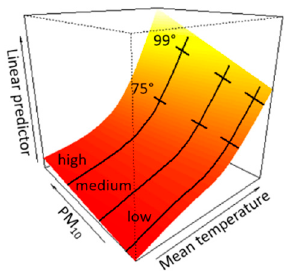
Figure 1. Example of the tensor smoother depicting the joint non-linear association between mean temperature and PM10 on non-accidental mortality. The graph shows the percentiles chosen to show effect estimates of temperature (75th and 99th percentiles of temperature distribution) and the sections corresponding to low, medium and high pollution values (5th, 50th, and 95th percentiles of PM10